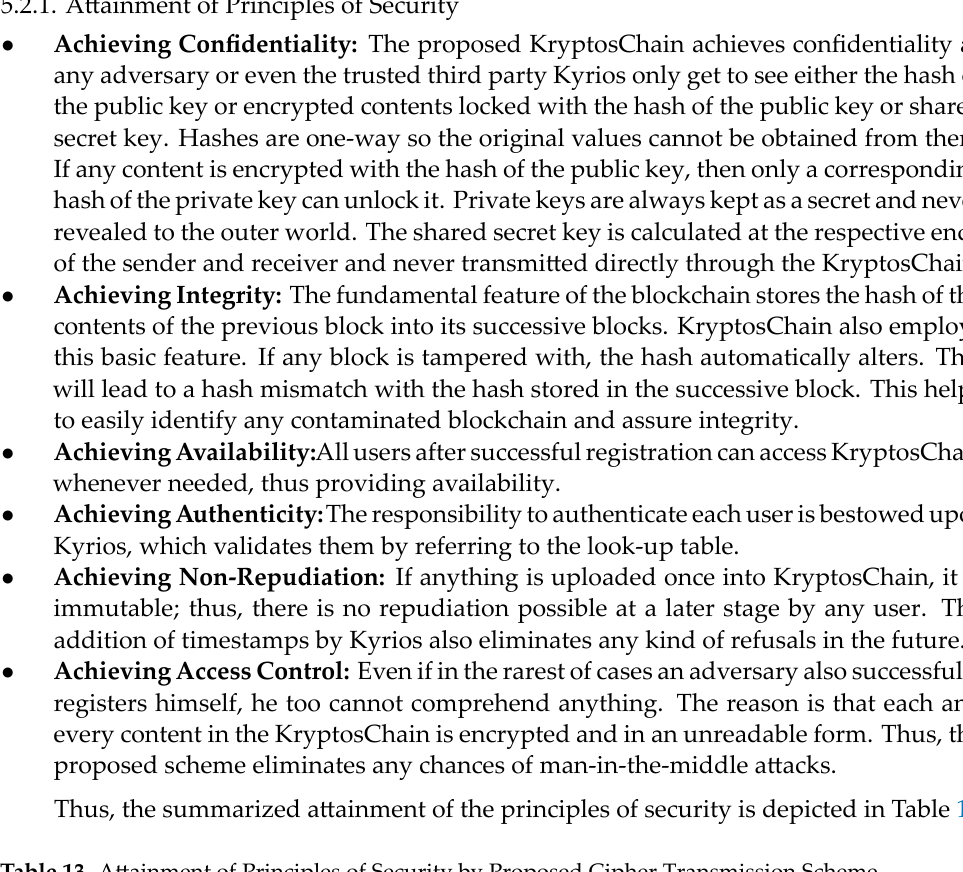
Table 13. Attainment of Principles of Security by Proposed Cipher Transmission